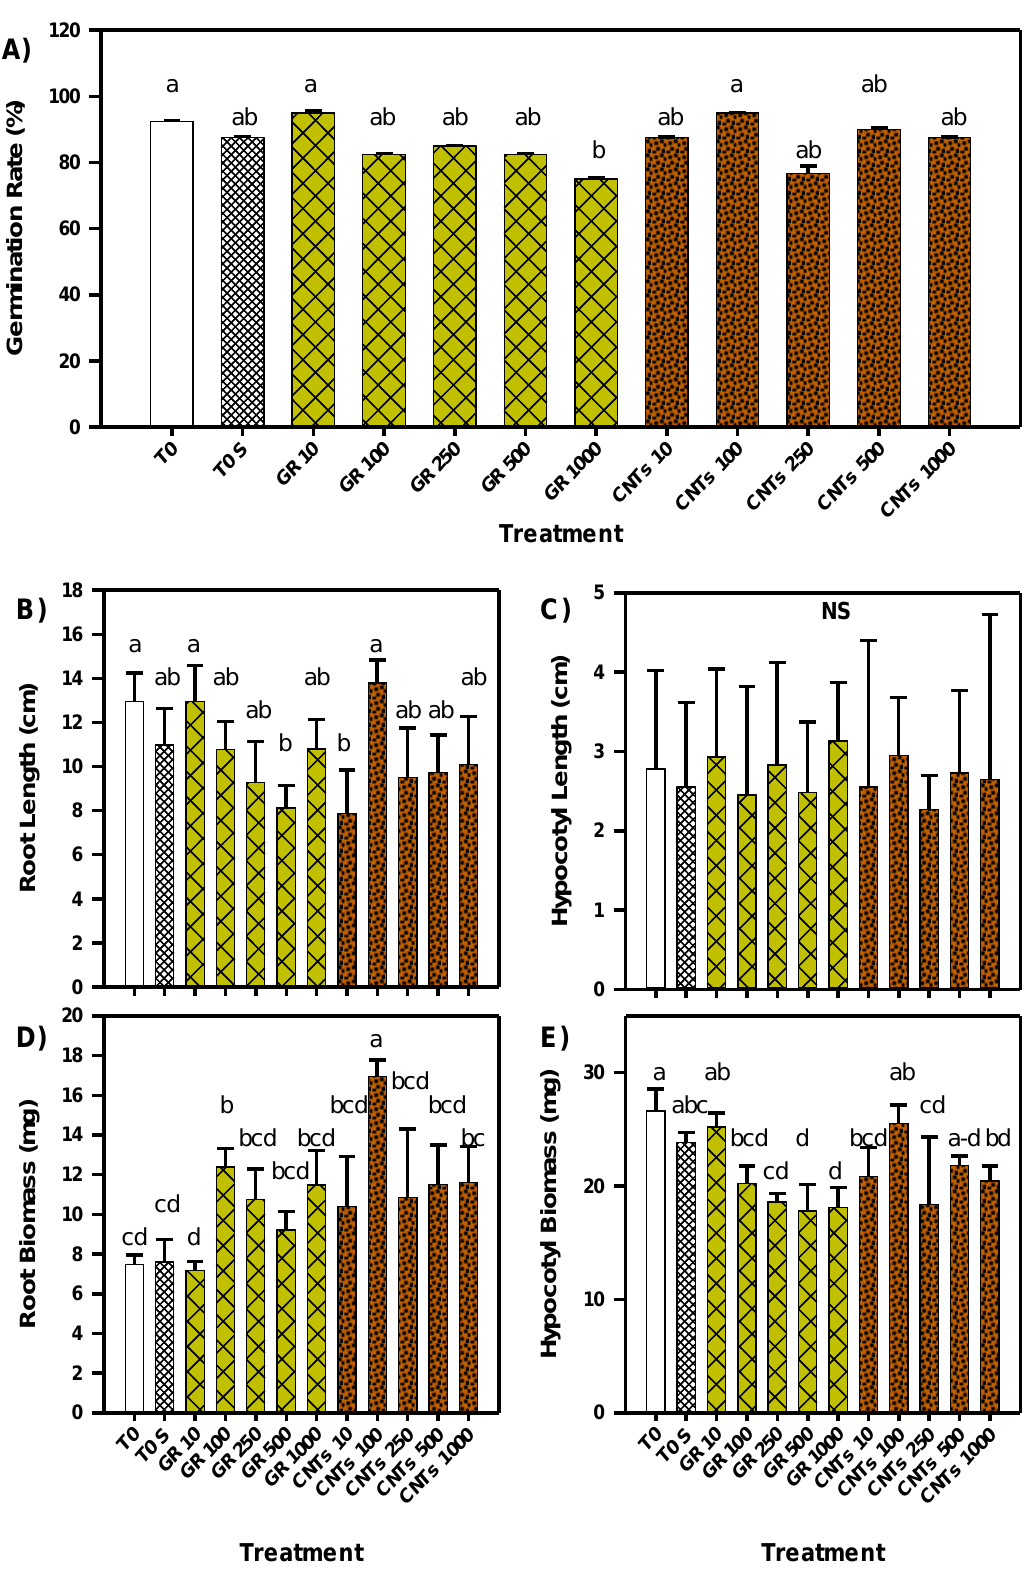
Figure1. Germination variablesevaluated intomato seeds treated with carbon nanomaterials. Each data Figure 1. Germination variables evaluated in tomato seeds treated with carbon nanomaterials. Each point is the average of four replicates ± standard error. Di ff erent letters indicate significant di ff erences data point is the average of four replicates ± standard error. Different letters indicate significant between treatments according to Fisher’s least significant di ff erence test ( p ≤ 0.05). T0: absolute control. differences between treatments according to Fisher’s least significant difference test ( p ≤ 0.05). T0: T0 S: sonicated control. GR: graphene. CNTs: carbon absolute control. T0 S: sonicated control. GR: graphene. CNTs: carbon nanotubes.